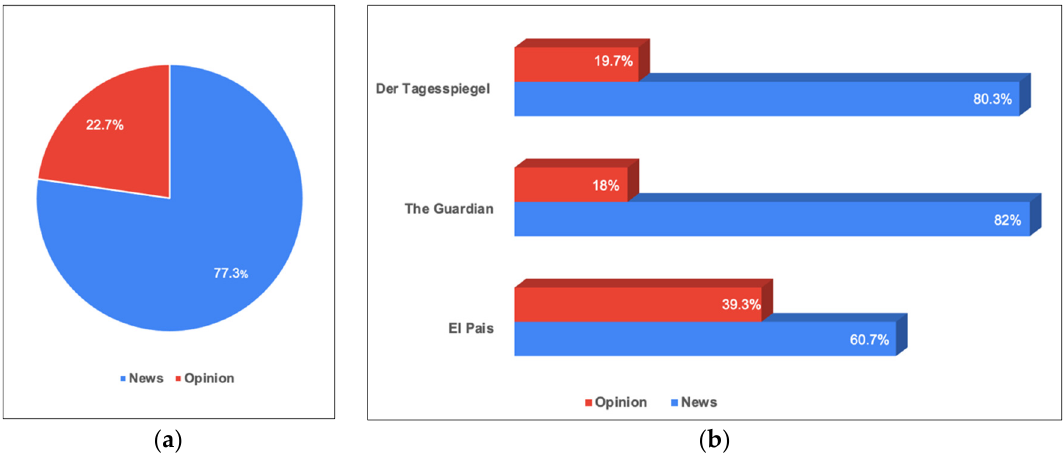
Figure 2. ( a ) Type of text in the sample; ( b ) distribution by media outlet and type of